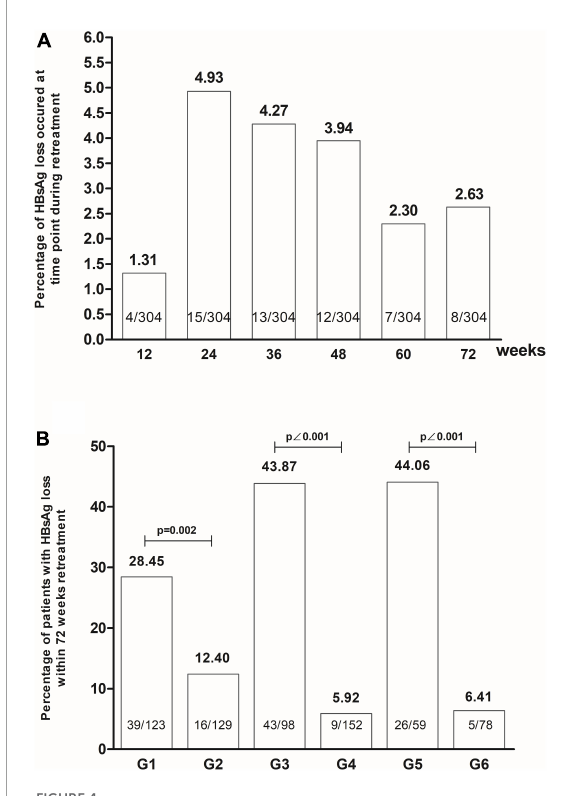
FIGURE4 The HBsAg loss occurred at the time of retreatment (A) , and the patients with early HBsAg response had high rates of HBsAg loss by retreatment (B) (G1: Group with early HBsAg response at initial treatment. G2: Group without early HBsAg response at initial treatment. G3: Group with early HBsAg response at retreatment. G4: Group without early HBsAg response at retreatment. G5: Group with early HBsAg response at initial treatment and at retreatment. G6: Group without early HBsAg response initial treatment and at